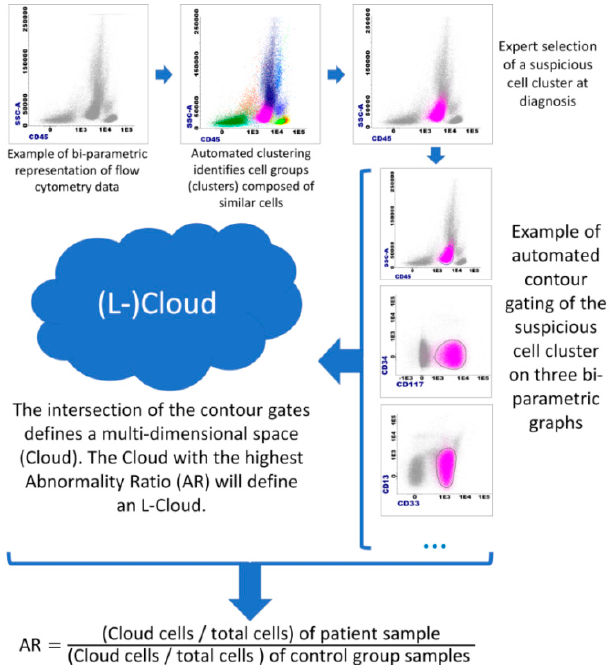
Figure 2. The principle of the “Cloud”, “L-Cloud”, and “Abnormality Ratio” concepts; AR: Abnormality Ratio. Infinicyt software (Cytognos, Salamanca, Spain) was used for flow cytometry data representation, automated clustering ( k -nearest neighbor-based clustering), and automated contour gating (two-dimensional kernel density estimation).